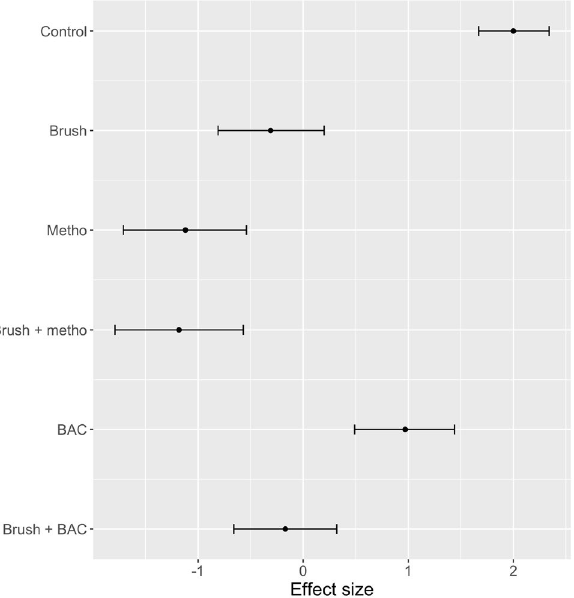
Figure 13. Effect size (estimate and 95% confidence interval of generalised linear mixed models) for components of Equipment 1 across all soil and moisture types: Control = no hygiene; Brush = brushing with a handheld brush; Metho = spraying with 70% methylated spirits; BAC = spraying with 2% BAC; 95% confidence intervals that do not overlap can be considered significantly different. Positive effect values indicated that treated boots retained P. cinnamomi